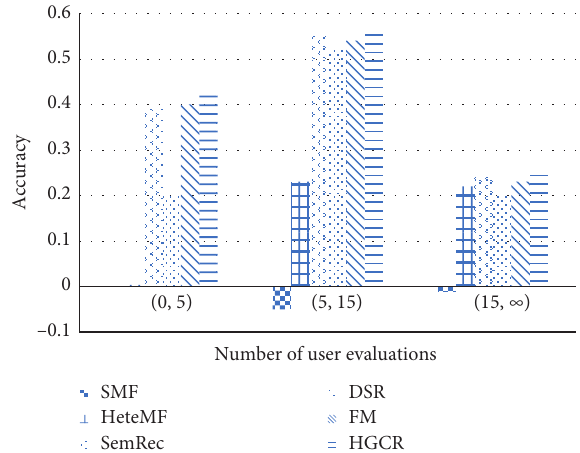
Figure 11: Performance of cold start on Douban Book.